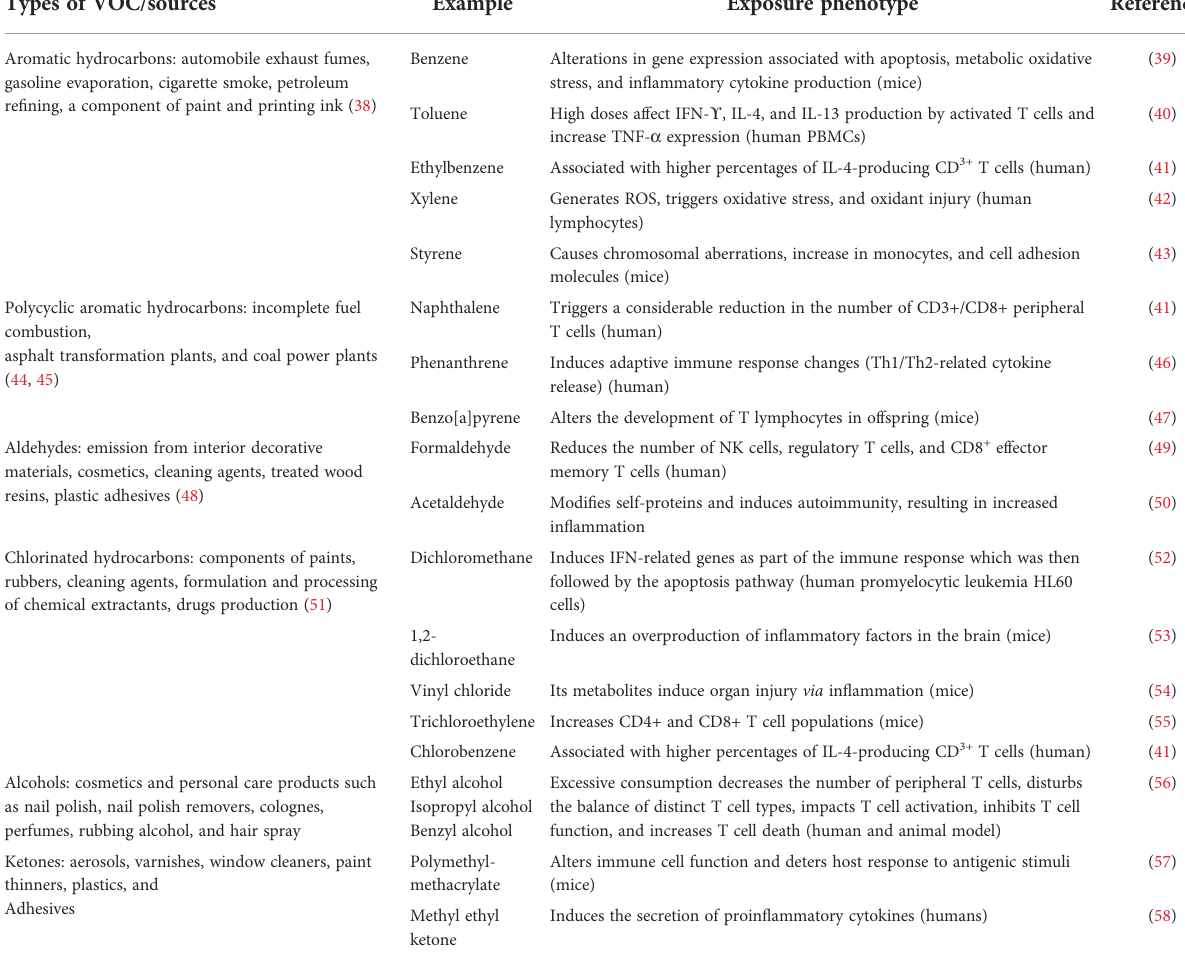
TABLE 1 Various volatile organic compound (VOC) types and their exposure